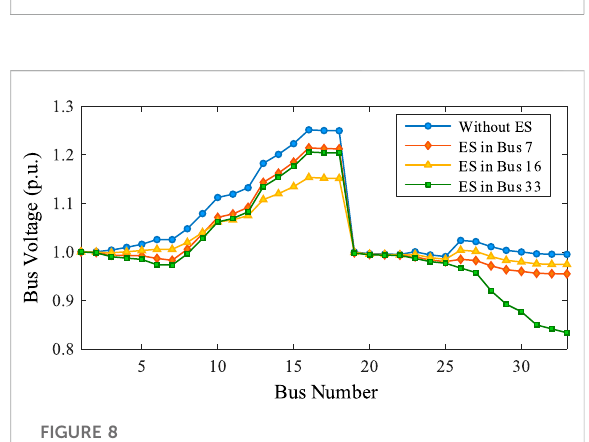
FIGURE 7 Voltage distributions with different PV capacities.